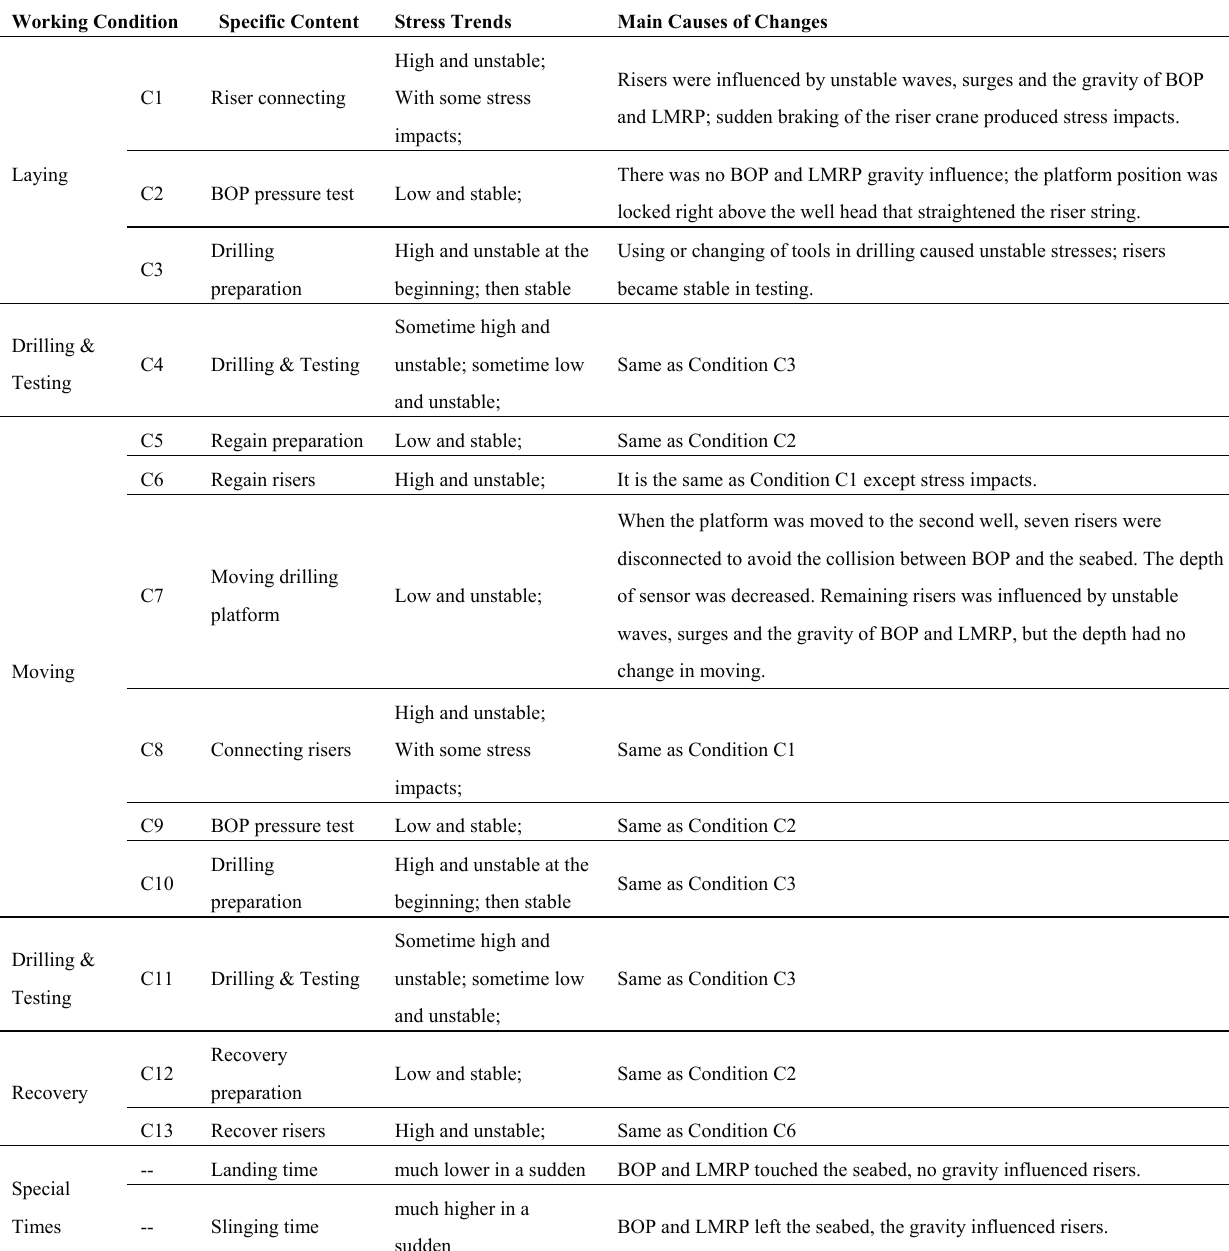
Table 2. Stress trends under different detailed